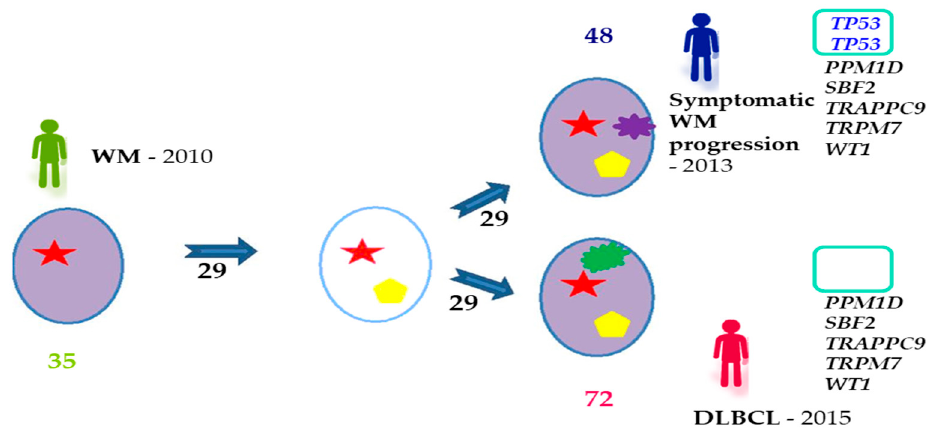
Figure 2. Branching model of tumor evolution observed in WM transformation to DLBCL, adapted from Jim é nez, C., Alonso- Á lvarez, S., Alcoceba, M. et al. From Waldenström’s macroglobulinemia to aggressive diffuse large B-cell lymphoma: a whole-exome analysis of abnormalities leading to transformation. Blood Cancer J. 7, e591 (2017). https://doi.org/10.1038/bcj.2017.72 [87]. The figure shows an example from a patient who was diagnosed with WM in 2010 and who transformed to DLBCL in 2015, with a symptomatic progression in 2013 before the transformation: 35 mutations were identified at diagnosis, 48 at relapse and 72 at transformation, and 29 of the alterations were conserved throughout the entire process. Mutations in PPM1D , SBF2 , TRAPPC9 , TRPM7, and WT1 genes were present at progression and transformation. By contrast, two TP53 mutations at relapse that were not observed at transformation. This implies that the transformed final clone did not evolve from the same subclone as was responsible for progression, but from a previous one that would not yet have acquired the TP53 mutations. DLBCL, diffuse large B-cell lymphoma; WM, Waldenström’s macroglobulinemia.